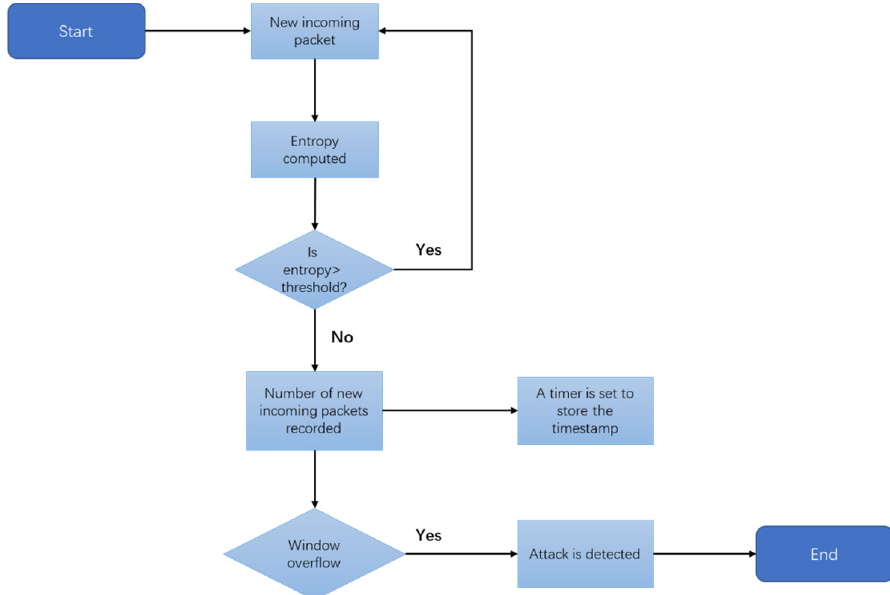
Figure 2. Flowchart of attack detection method.